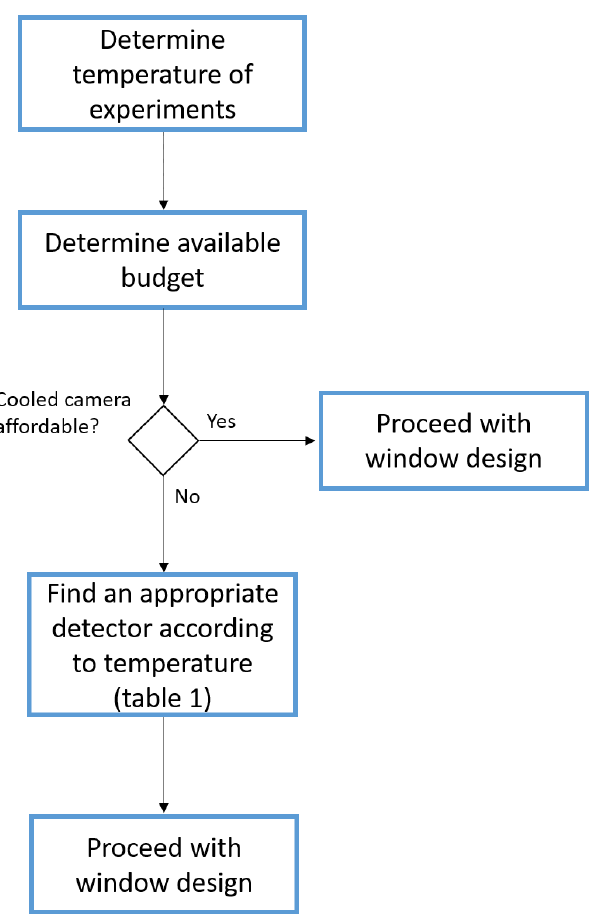
Figure 2. Decision tree for the selection of IR camera for catalytic reaction investigation.